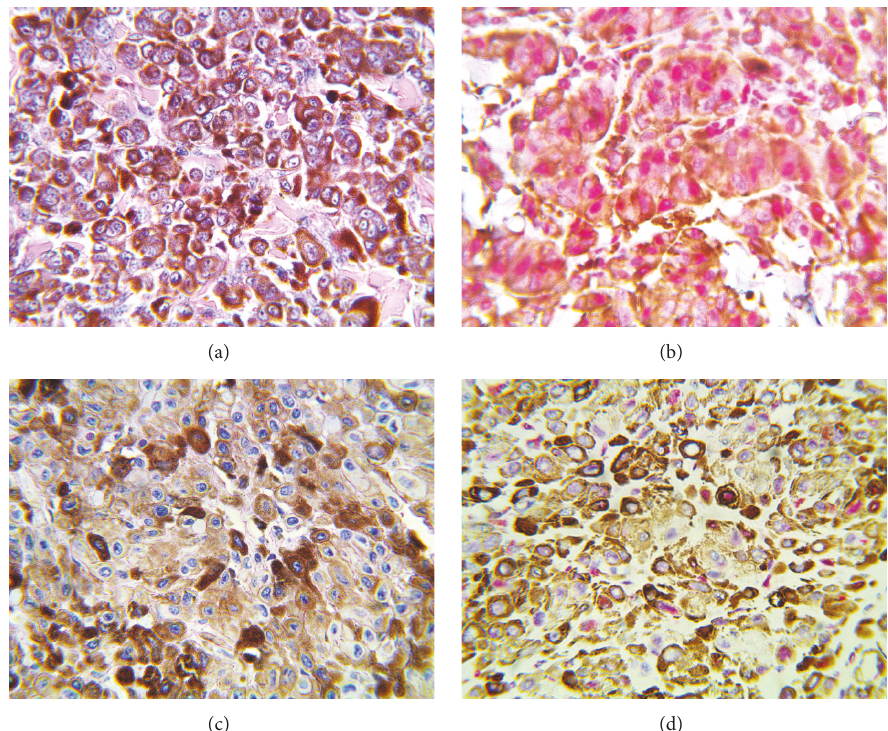
Figure 2: (a) Photomicrograph of case 17 stained with H&E (Magnification x 400). The tumour cells are heavily pigmented; (b) photomicro- graph showing red nuclear staining of case 17 by the anti-CDKN2A/p16INK4a antibody (Magnification X 400); (c) photomicrograph of case 12 stained with H&E (Magnification x 400). The tumour cells are heavily pigmented; (d) photomicrograph showing no nuclear staining by the anti-CDKN2A/p16INK4a antibody (magnification X